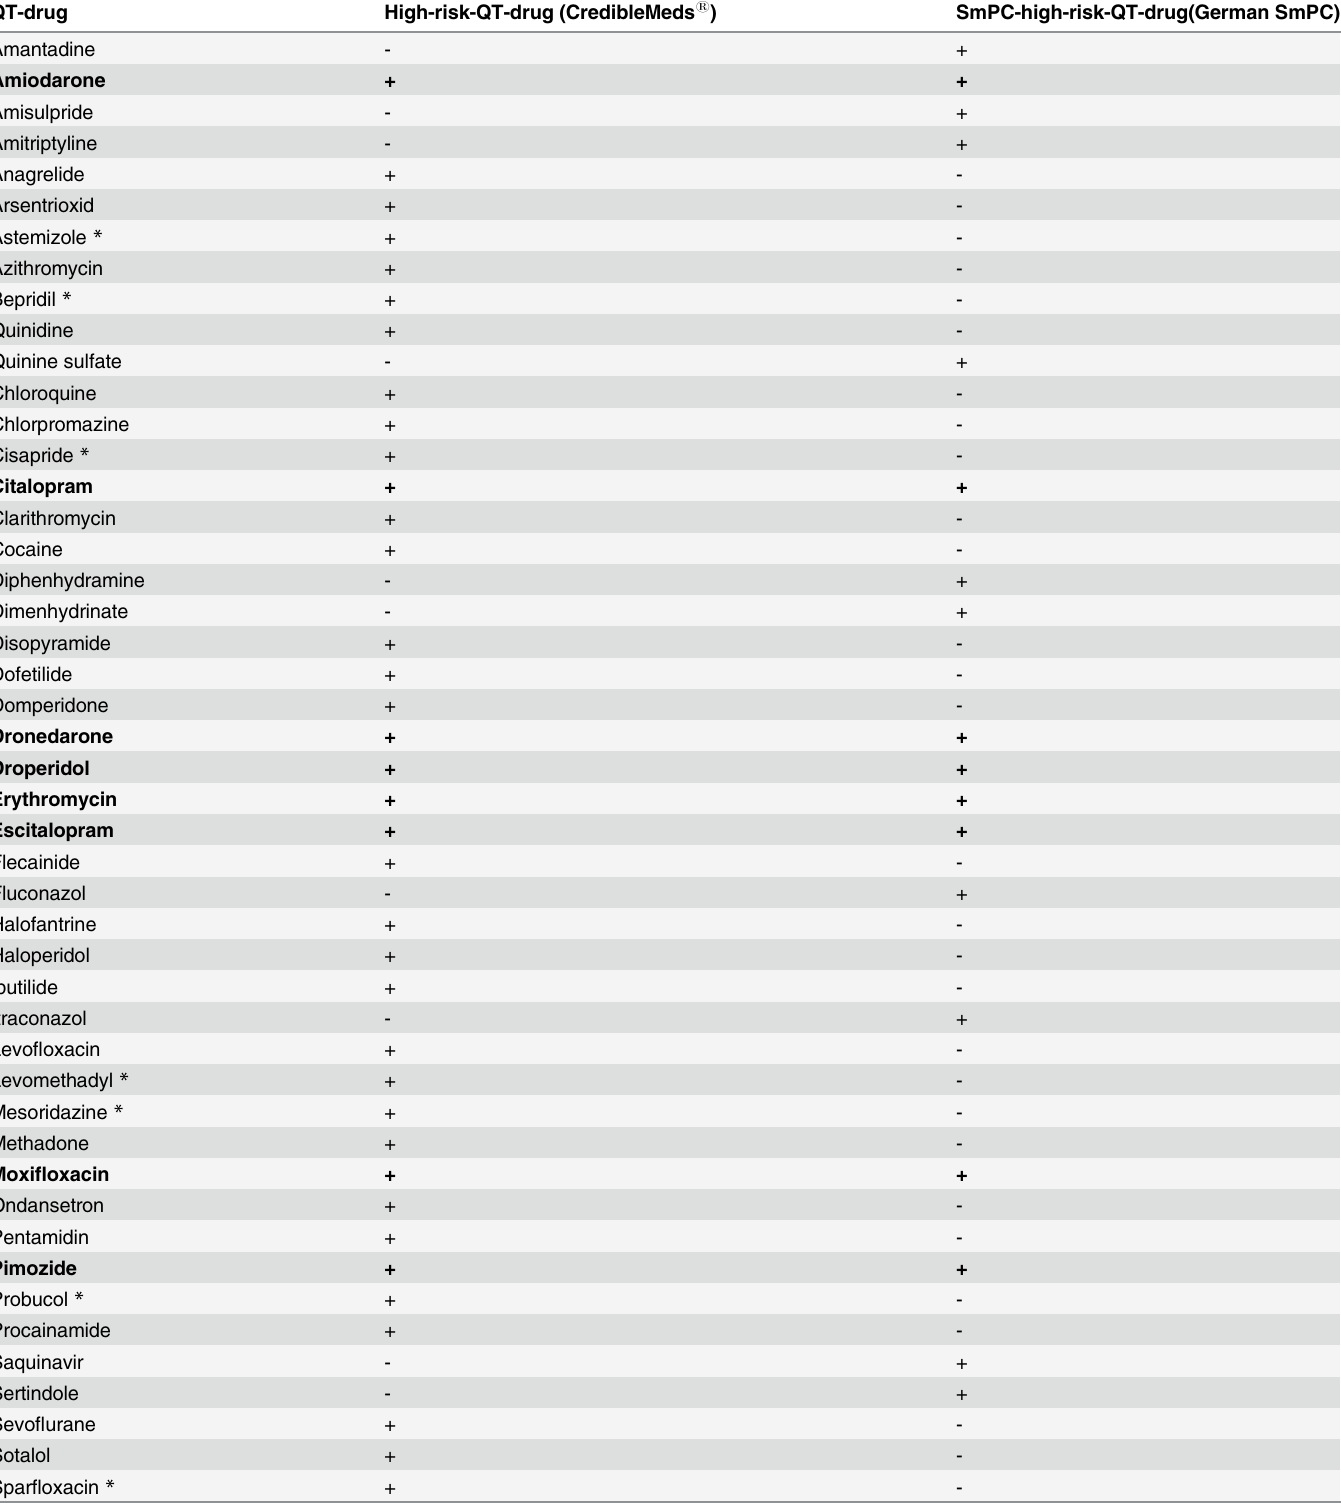
Table 1. High-QT-drugs and SmPC-high-risk-QT-drugs. QT-drug High-risk-QT-drug (CredibleMeds 1